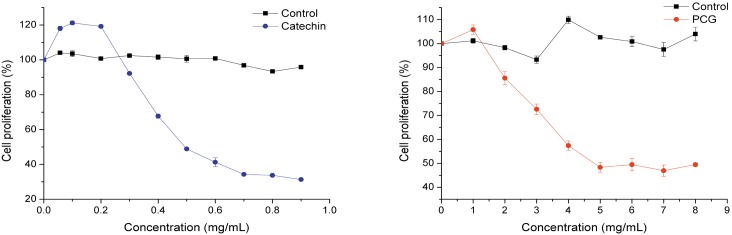
Percent inhibition of human HepG2 liver cancer cell proliferation by catechin and PCG.